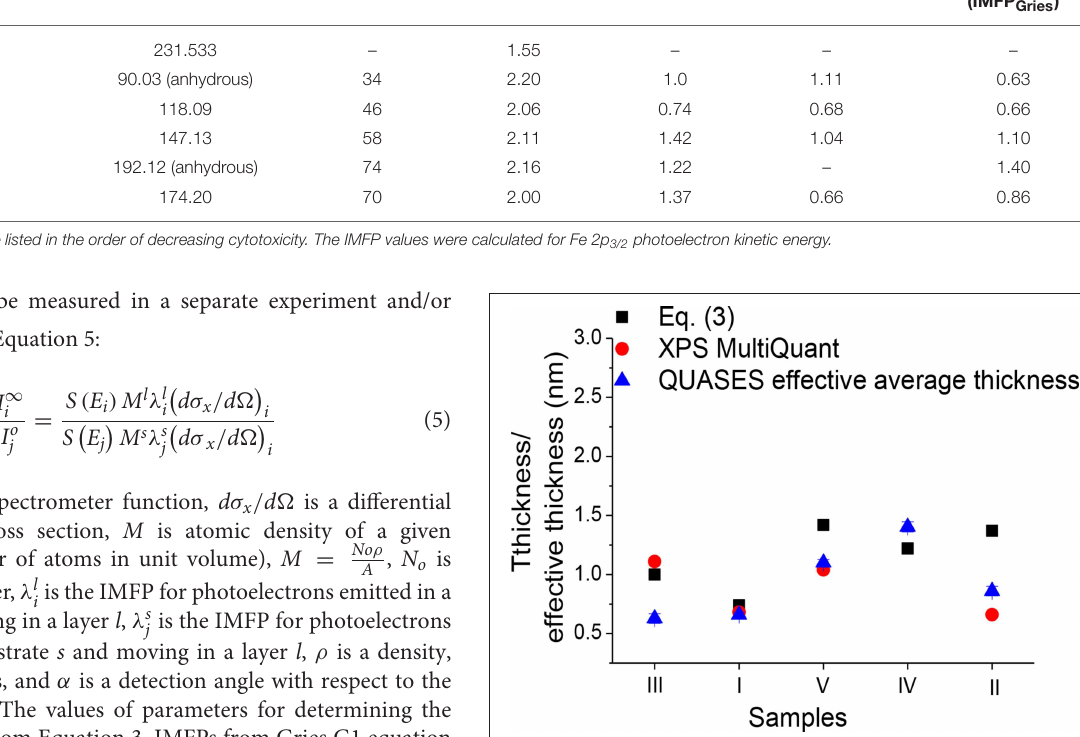
shown in Figure 10 . The electron scattering probabilities (elastic peak intensities) at 0 eV and inelastic scattering probabilities on valence band electrons in the region of about 80 eV above